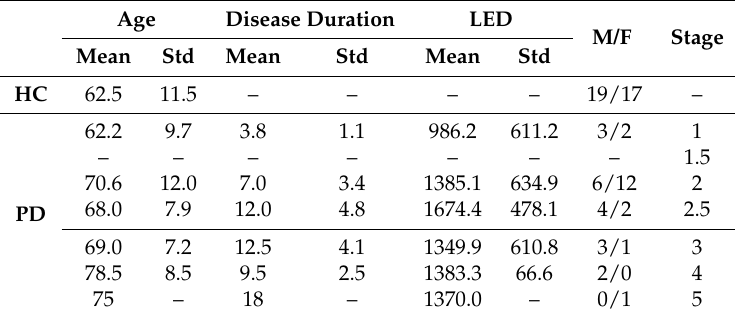
Table 1. PaHaW dataset. A line divides the Parkinson’s disease (PD) group into two subgroups depending on the disease severity: early to mild vs. mild to severe. In the present work, only the healthy control (HC) group and the early to mild subgroup have been taken into account. Age Disease Duration LED M/F Stage Mean